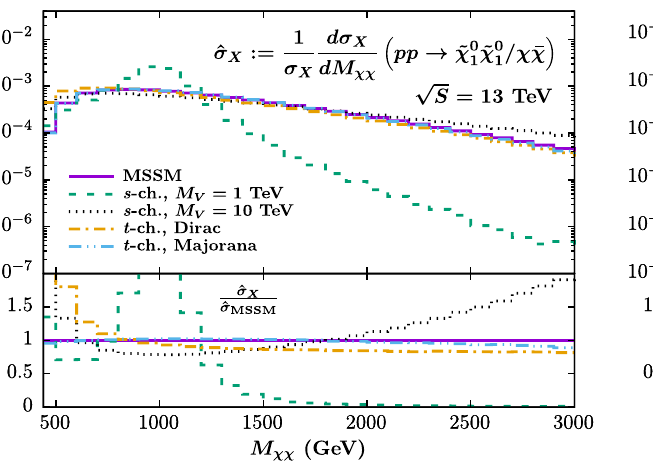
with M V = 1 TeV (dashed green line) and M V = 10 TeV (dotted black line), and the t -channel model with DM as a Dirac (dash-dotted yellow line) and a Majorana (dash-double dotted blue line)